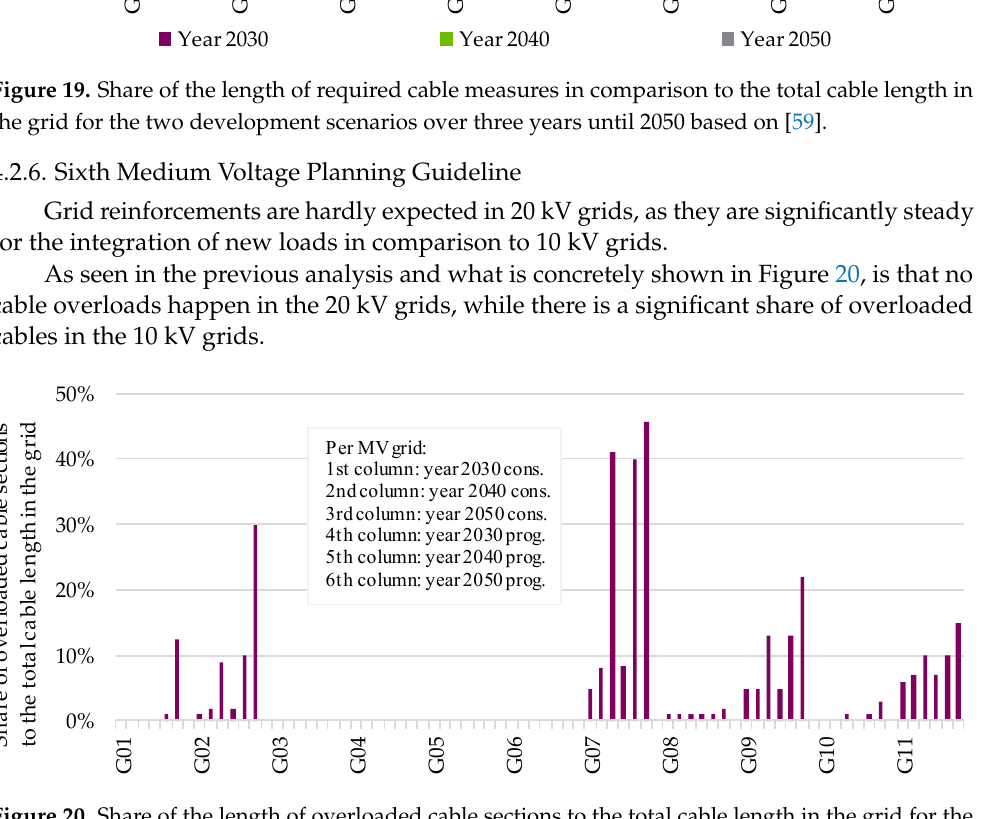
Figure 21. Maximum voltage drop and maximum voltage saving consolidated over eleven MV grids for the two development scenarios over three years until 2050 based on [59]. Figure 21 shows that the complete voltage range (4% V / V n ) is not utilized in any of the cases. In the year 2030, approximately half of the voltage range is needed. In the years afterward, the required voltage in the MV level increases gradually. This proves that the initially set voltage range between MV and LV grids is actually not needed at the MV level. Depending on the planning criteria in the LV level, a new voltage division between